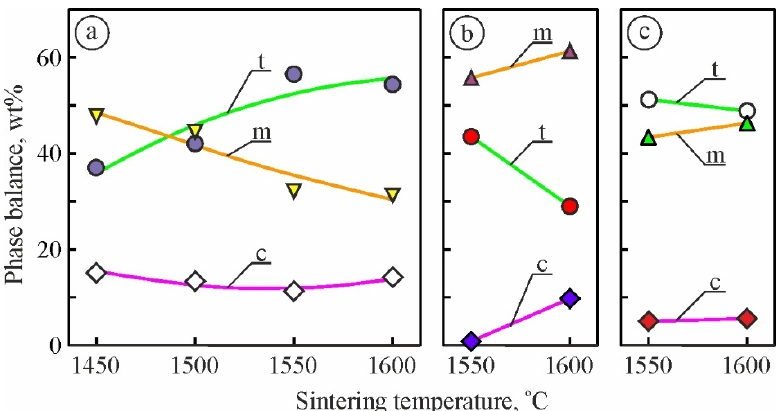
Figure 1. Changes in the zirconia phase balance of the investigated materials of variants ( a ) 6YSZ-1450, 6YSZ-1500, 6YSZ-1550, 6YSZ-1600, ( b ) 7YSZ-1550, 7YSZ-1600, and ( c ) 8YSZ-1550, 8YSZ-1600 depending on the sintering temperature (see Table 1). Phase marking: t—tetragonal, m—monoclinic, c—cubic.